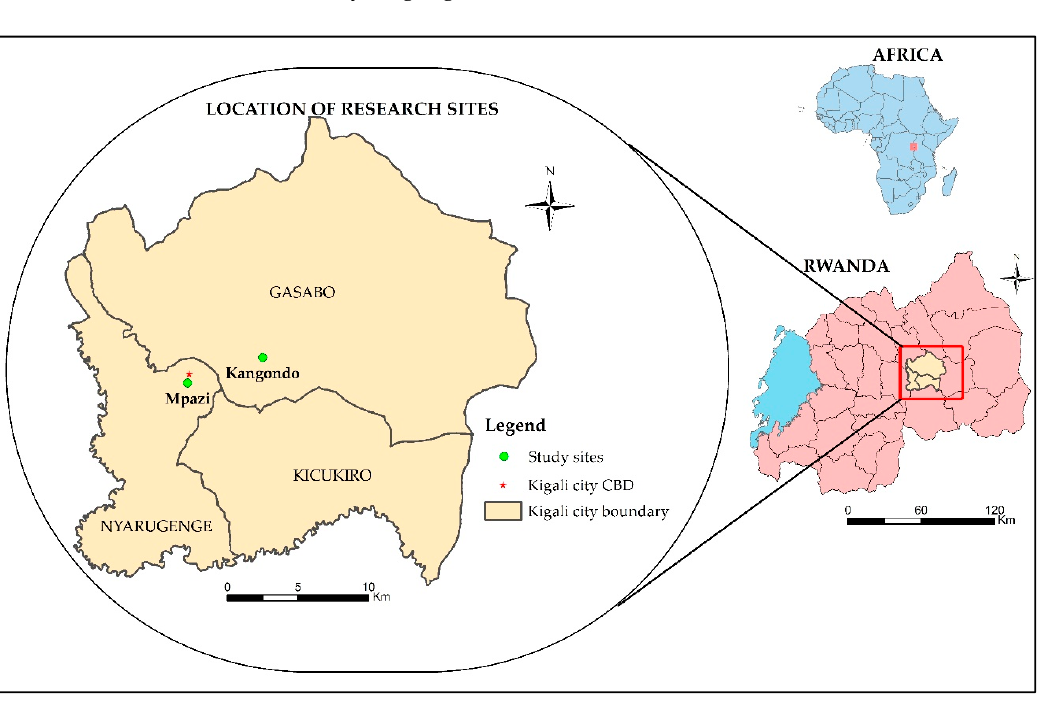
Figure 1. Map of Kigali City and the selected research sites. Source: Authors. 264